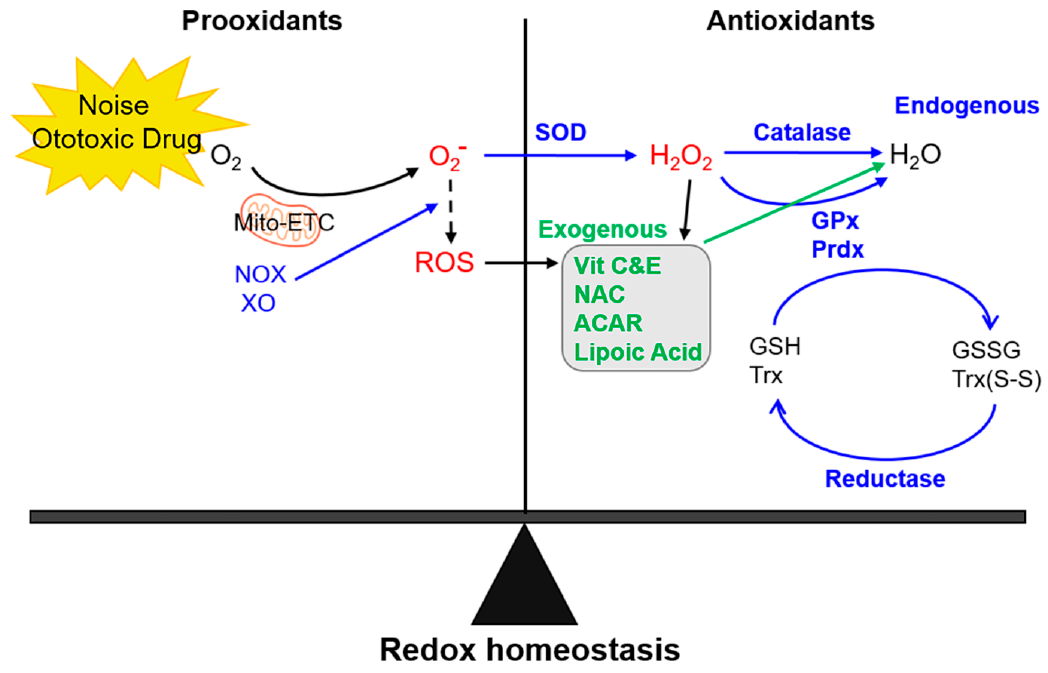
Figure 1. Mechanism of redox homeostasis. The balance between intracellular reactive oxygen species (ROS) generation and exogenous and endogenous antioxidant effector mechanisms maintains acoustic integrity. The mitochondrial electron chain reactions, as well as NOX and XO activation, represent major sources of intracellular ROS, such as O 2 − , HO − , and H 2 O 2 . The blue letters and arrows indicate endogenous pathways and the green letters and arrows indicate exogenous pathways. Mito-ETC, mitochondrial e − transport chain reactions; NOX, NADPH oxidase; XO, xanthine oxidase; NAC, N -acetyl cysteine; ACAR, acetyl-L-carnitine; SOD, superoxide dismutases; GPx, glutathione peroxidases; PRDXs, peroxiredoxins; TRX, thioredoxins.